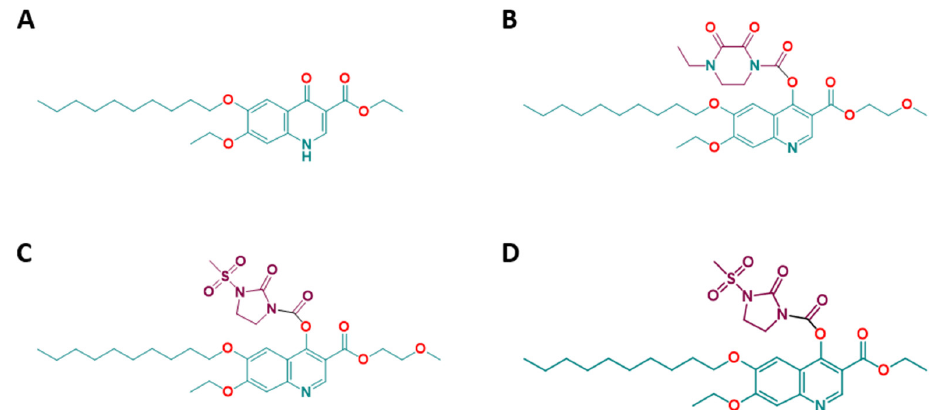
Figure 1. Structures of decoquinate (DCQ) and its quinoline– O -carbamate derivatives. ( A ) DCQ, C 24 H 35 NO 5 , MW = 417.546; ( B ) RMB054, C 32 H 45 N 3 O 9 , MW = 615.724; ( C ) RMB055, C 30 H 43 N 3 O 10 S, MW = 637.745; ( D ) RMB060, C 29 H 41 N 3 O 9 S, MW = 607.719.